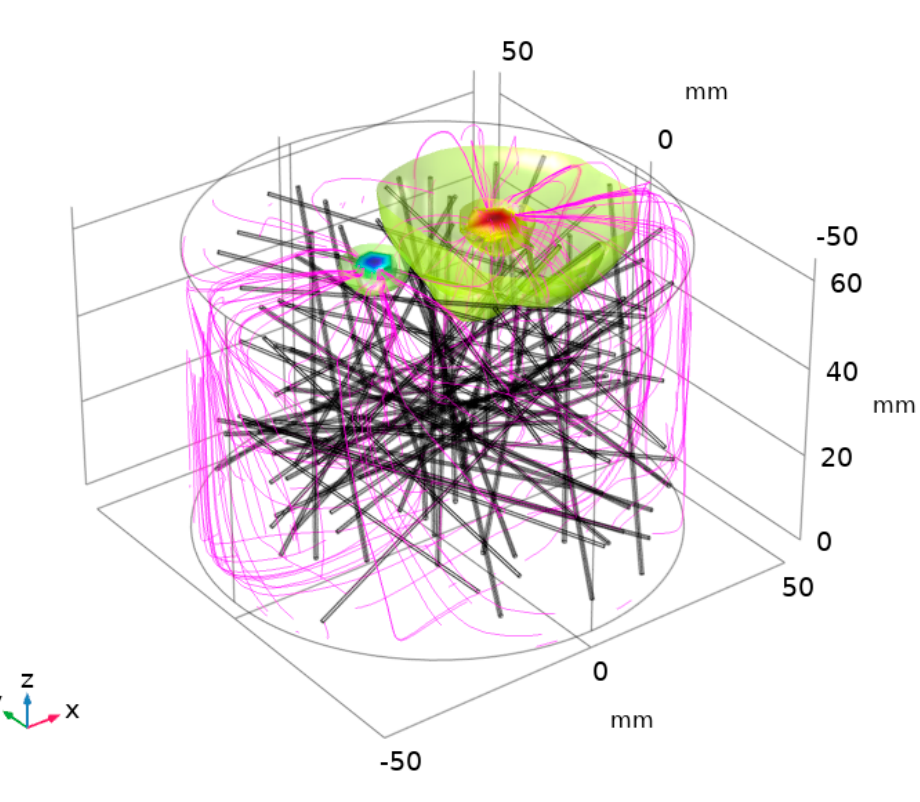
Figure 5. Electrical conductivity lines in the simulated model. Figure 6 indicates that increasing steel fiber content reduces the surface electrical re- sistivity. Table 3 provides a summary of reduction rates using exponential regressions. Disregarding a few outliers, it is evident from results that a higher aspect ratio of fibers results in higher rates of reduction in the electrical resistivity. Furthermore, the electrical resistivity is dropped sharper for shorter fibers with the same aspect ratio.